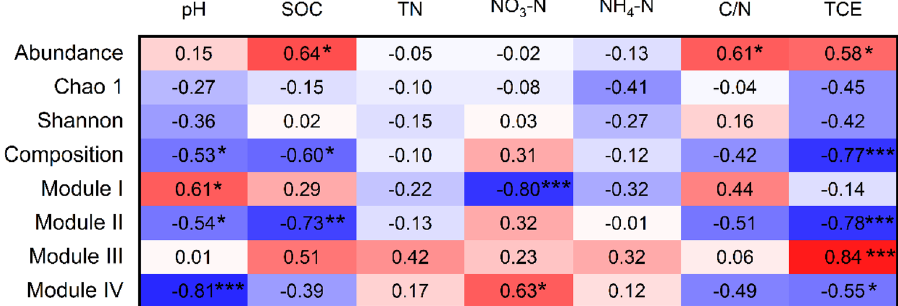
Figure 4. The relationships between the bacterial community, soil properties, and CO 2 emission. SOC, soil organic carbon; TN, total nitrogen; NO 3 -N, nitrate nitrogen; NH 4 -N, ammonium nitrogen, C/N ratio, SOC to